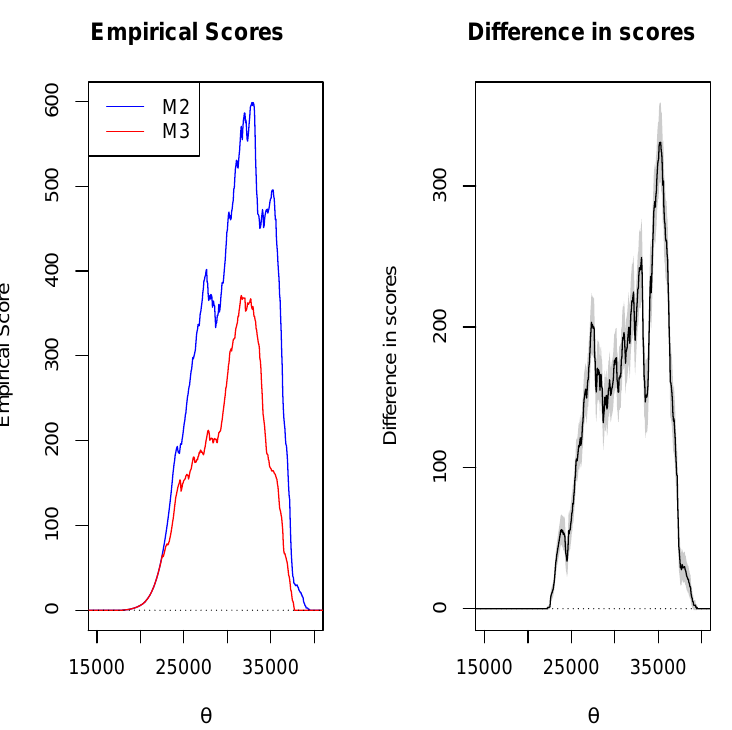
Figure 12. Murphy diagrams for the comparison of the 0.99 quantiles of Extremal99 and NLQR99 (M2 and